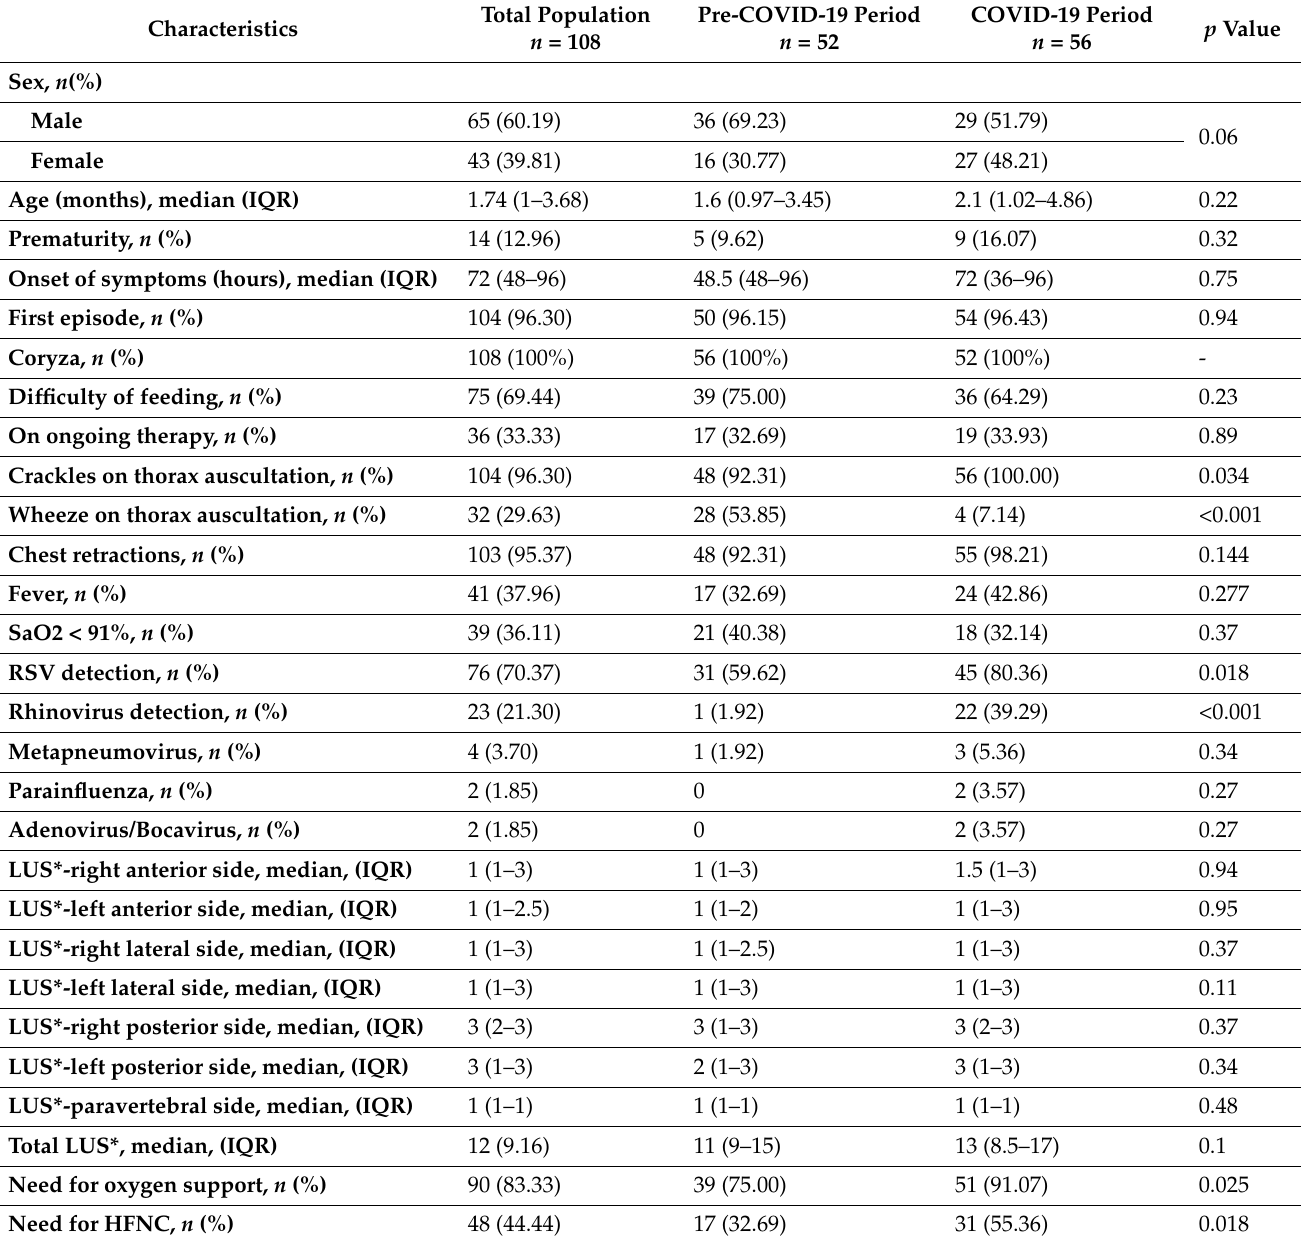
Table 1. Basic characteristics of the study